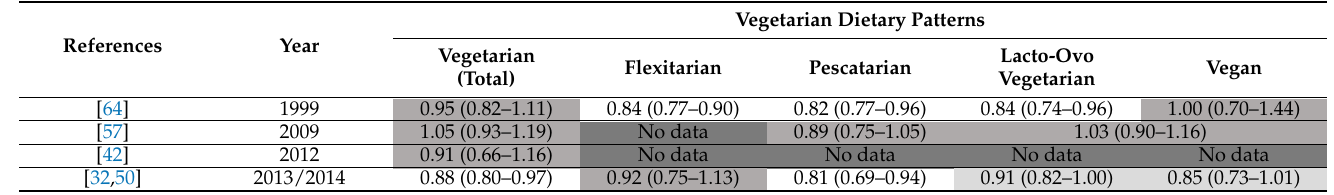
Table 1. All-cause mortality of vegetarian dietary patterns compared to the omnivorous reference diet.